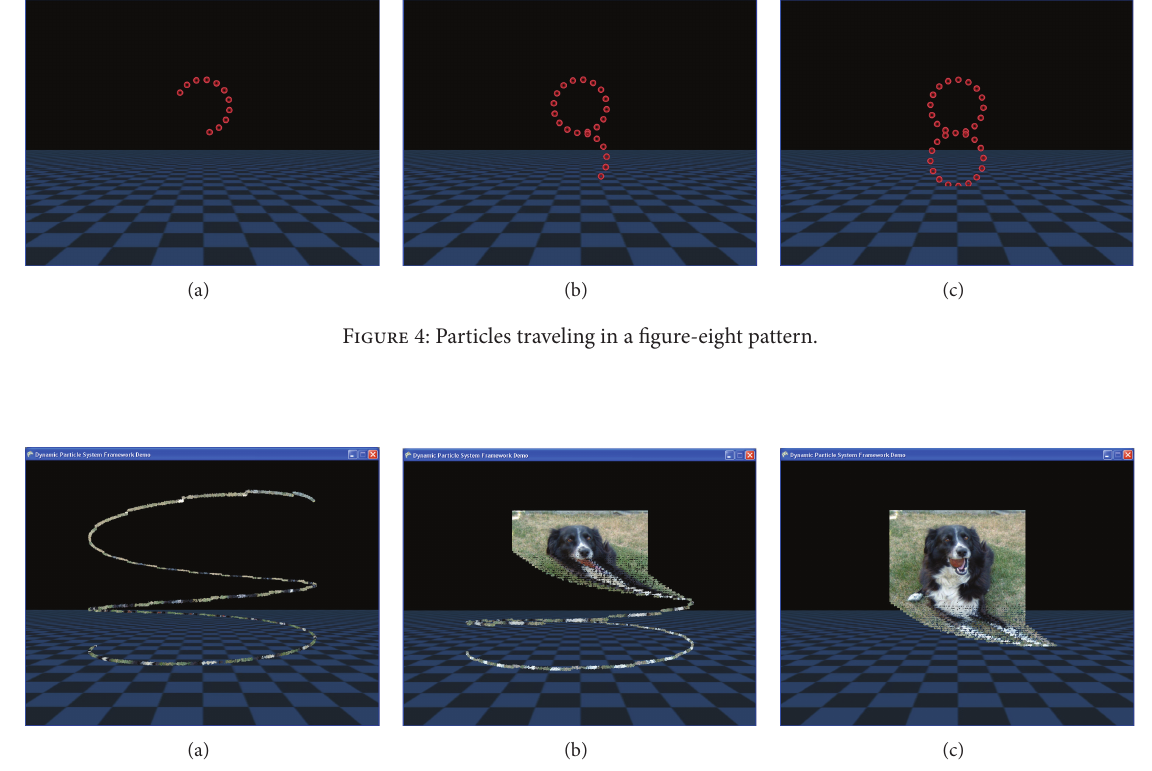
Figure 5: Particles traveling in a spiral before coming to rest at their final positions, which forms an